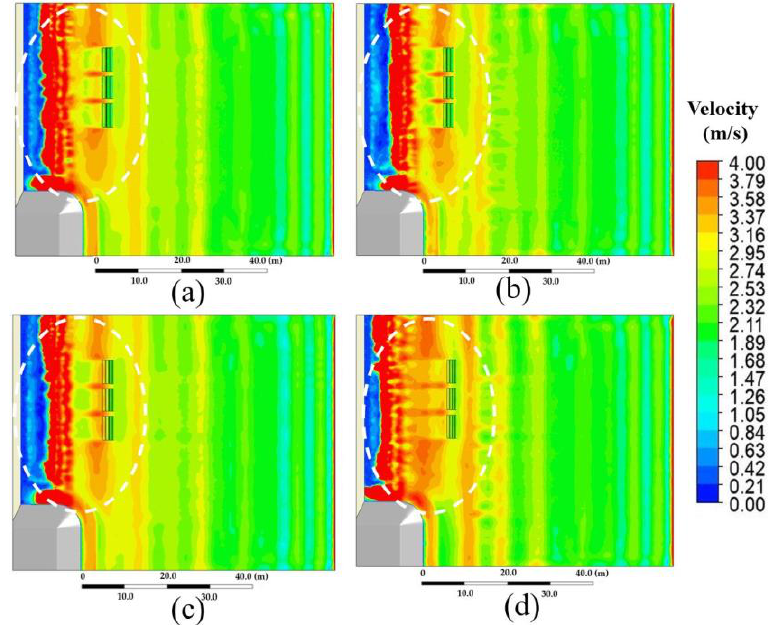
Figure 13. The water velocity of ( a ) P1/10°, ( b ) P1/15° , ( c ) P1/30° , and ( d ) P1/45°.